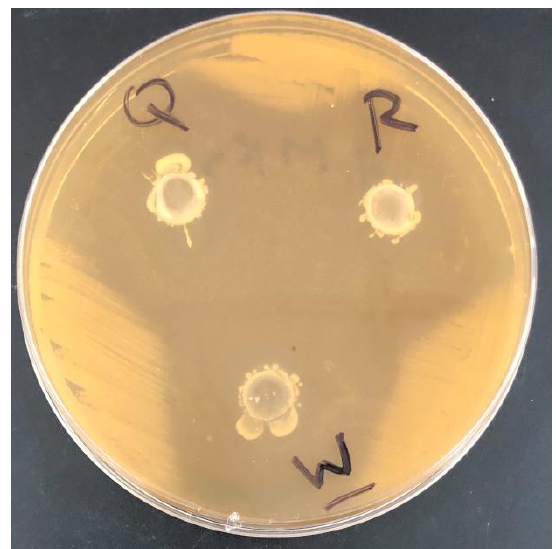
Fig. 5: Modified double layer method. Clear zones around the wells containing Lactobacillus growth representing the inhibiting activity of lactobacillus against S. aureus. R= L. rhamnosus, Q= L. casei, W= L. fermentum.